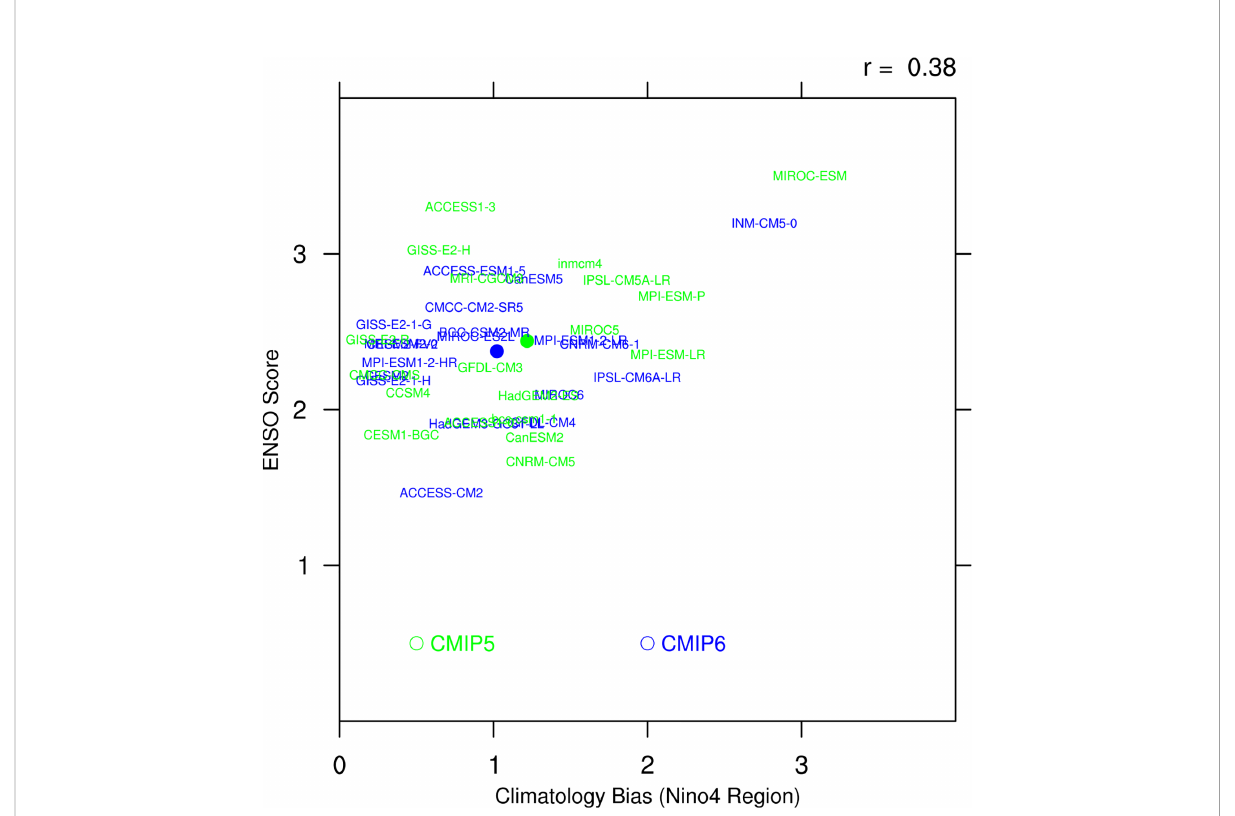
FIGURE 6 Scatterplots of the climatology bias of SST in the Niño4 region of CMIP models (horizontal axis, units: °C) and the ENSO score of CMIP models (vertical axis, units: 1). Green (blue) texts represent different CMIP5 (CMIP6) models listed in Table 1, and green (blue) dots denote the MME of CMIP5 (CMIP6)